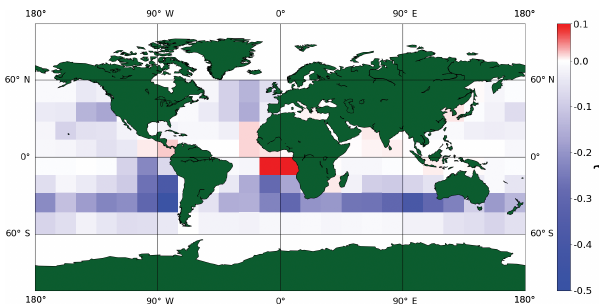
Figure 9. The sensitivity of CRE to aerosol ( λ ALL ) found on a re- gional basis with cloud state and environmental regime constraints. The total regime weighted, global warm cloud sensitivity to aerosol perturbations is − 10 . 13Wm − 2 ln(AI) − 1